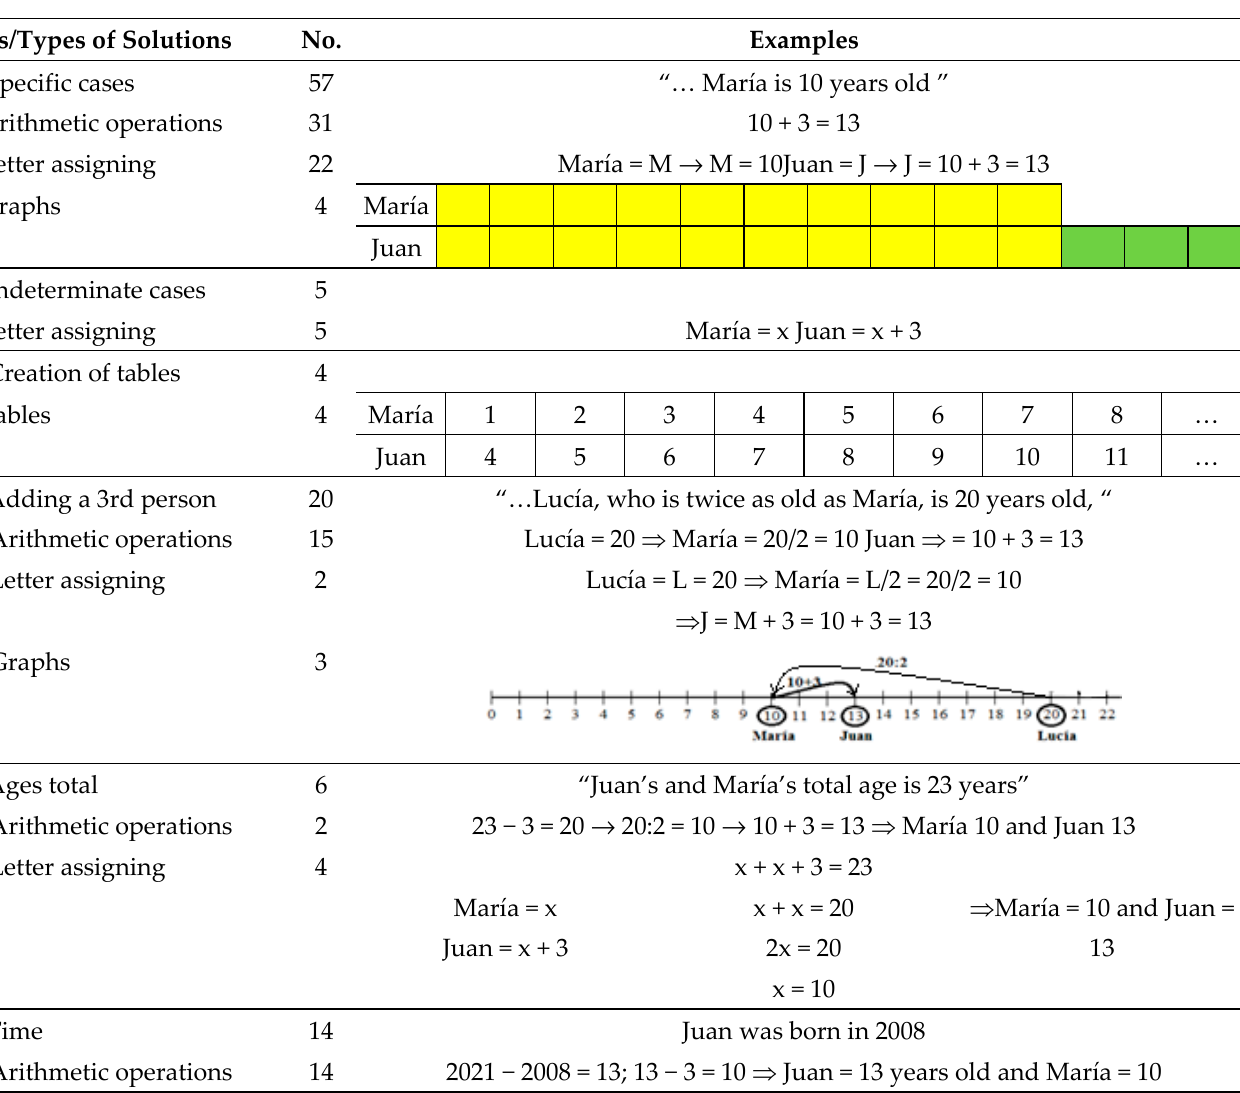
Table 3. Examples of resolution for case 1.